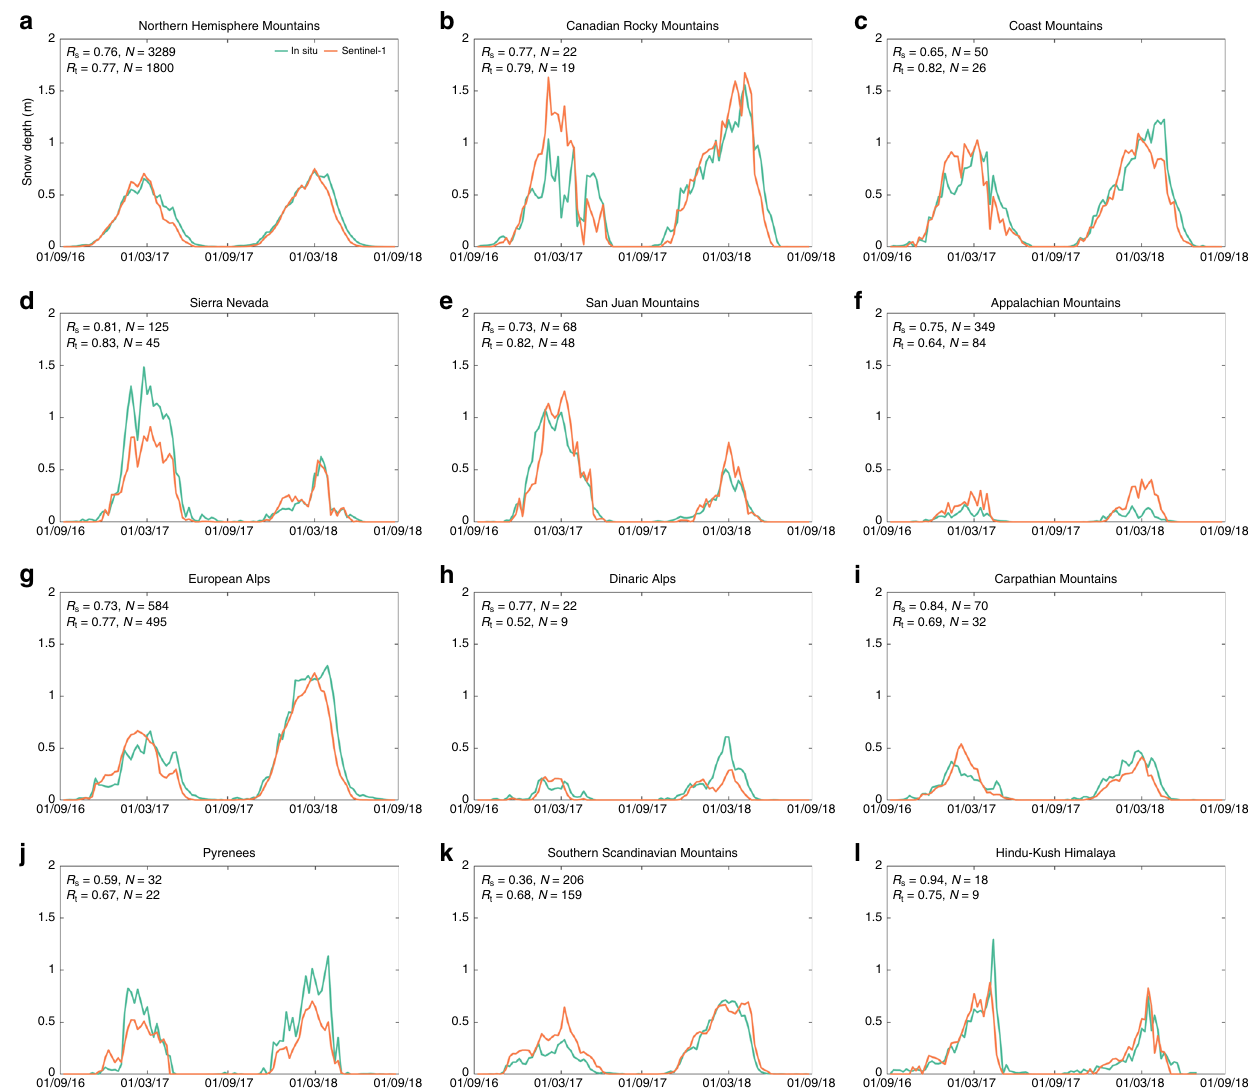
Fig. 5 Time series of snow depth measurements and retrievals. a The average weekly snow depth (m) over all measurement sites and corresponding Sentinel-1 grid cells across the Northern Hemisphere. b – l As in a, but averaged over the focus mountain ranges (Fig. 1b). The performance metrics shown in the top left of each fi gure include the temporal correlation ( R t ; dimensionless), the February spatial correlation ( R s ; dimensionless), and the number of sites ( N ; dimensionless) used to calculate the histogram in Fig. 6a) most frequently range between 0.8 and 0.9, have a mean of 0.77 (with signi fi cance level p < 0.01), and are distributed with a negative skew. When zero snow depths are excluded from the analysis (white histogram), the associated reduction in the snow depth range decreases the mean correlation ( R t = 0.65; p < 0.01). The lowest temporal correlations occur in sites with shallow snow depth and short or intermittent snow cover. The mean-absolute-error (MAE) histogram (Fig. 6b) has a positive skew, with values most frequently below 0.1 m and a mean of 0.18 m. When we exclude zero values from the analysis, the average MAE increases to 0.31 m. The bias (Fig. 6c) remains within ± 0.1 m for most of the sites, has a mean of − 0.01 m and a nearly normal distribution. Large errors (MAE and bias) can again originate from the differences in representativeness between point-scale measurements and grid-scale retrievals.